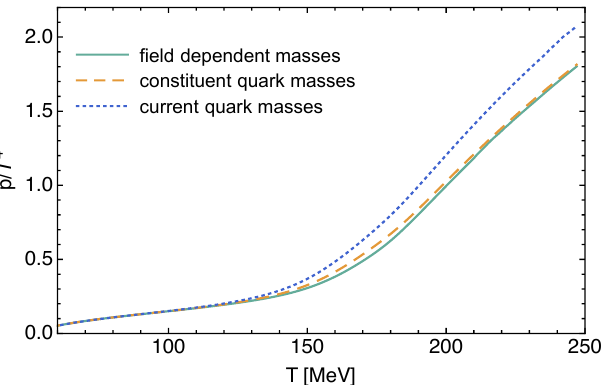
Figure 11: The pressure at µ = 0. The solid green line is computed with the full field dependence of ∆Γ Λ . The dotted blue line shows the results with m = 95 MeV. The dashed orange line correspond to m m s